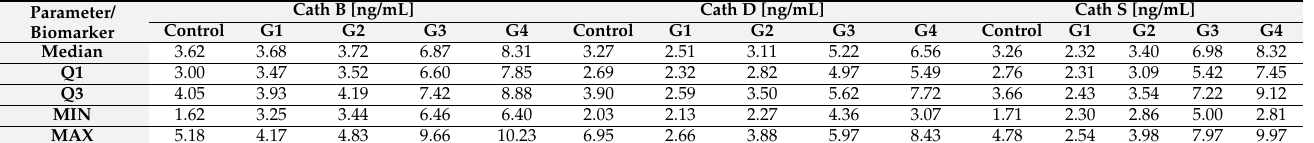
Table A1. Detailed data for Figure 1.